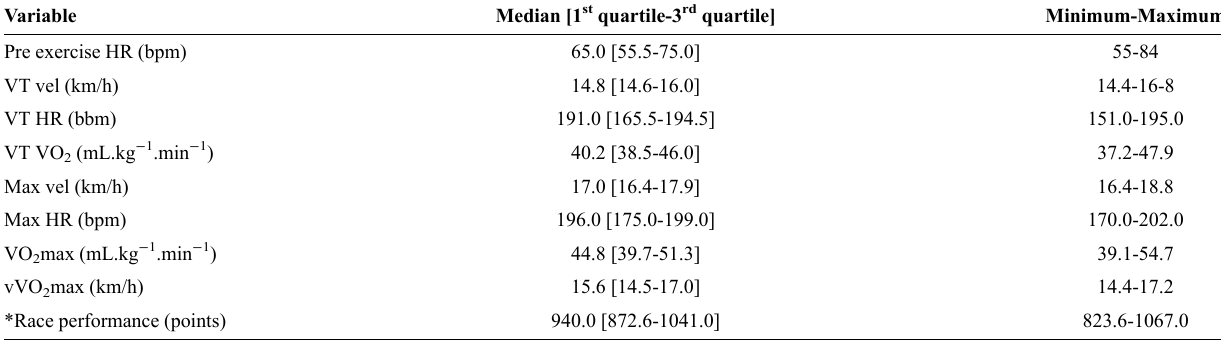
Figure 1 - Dispersion graph of vVO 2 points (velocity at the start of the VO 2 plateau) and performance in the race (n=5). The coefficient correla- tion (r) = 0.98 is classified as very strong, showing a significant relation- ship between race performance and vVO 2 max. Table 1 - Cardiopulmonary behavior under exercise and athletic performance in military pentathlon athletes from the Brazilian Army (n=5). Variable